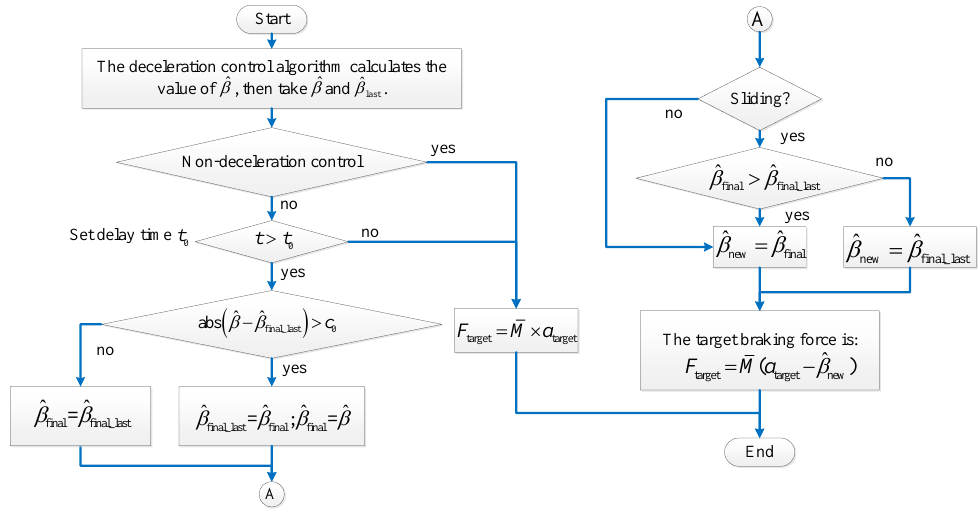
Figure 5. Deceleration control flow